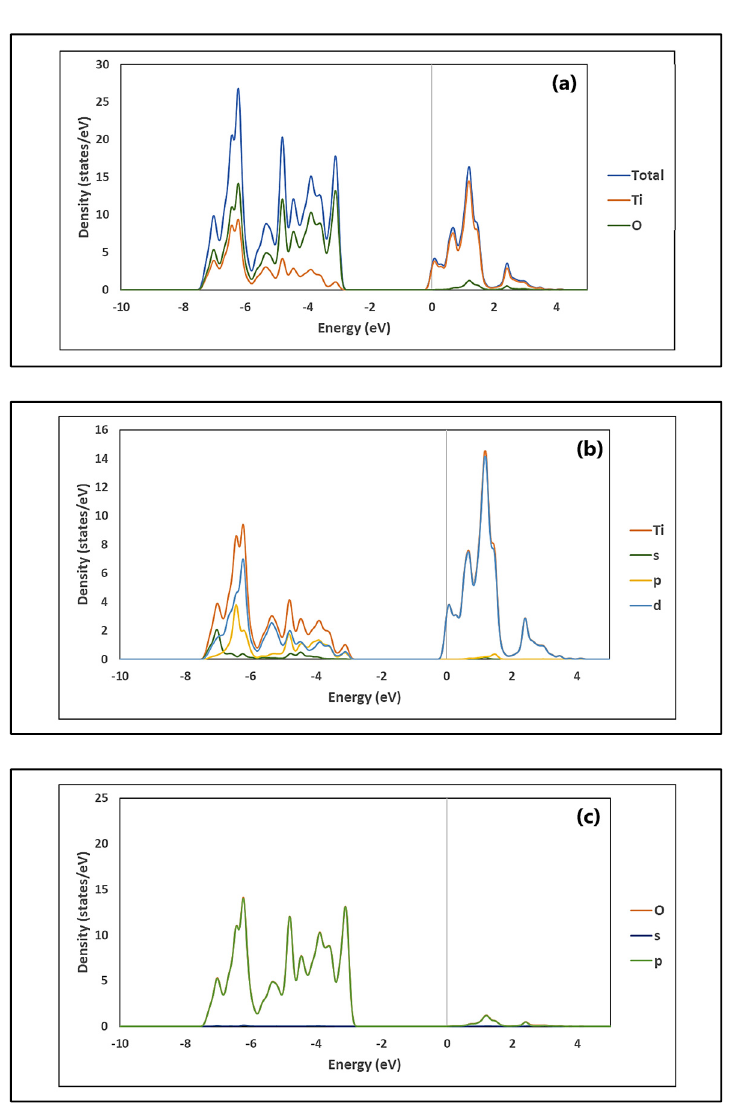
Figure 4. Density of states (DOSs) of TiO 2 : ( a ) total, and partial: ( b ) Ti and ( c ) O.